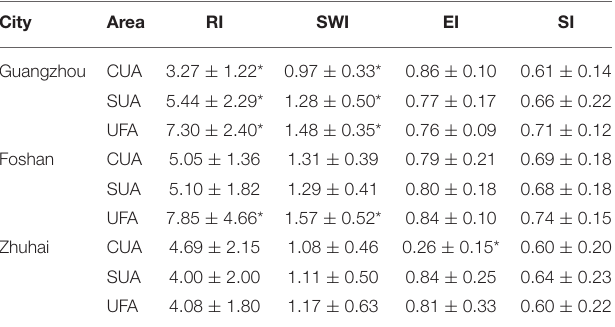
TABLE 4 | Values of ecological diversity and evenness indexes with standard deviations of CUA, SUA, and UFA in Guangzhou, Foshan, and Zhuhai, including richness index (RI), Shannon-Wiener index (SWI), evenness index (EI), and Simpson index